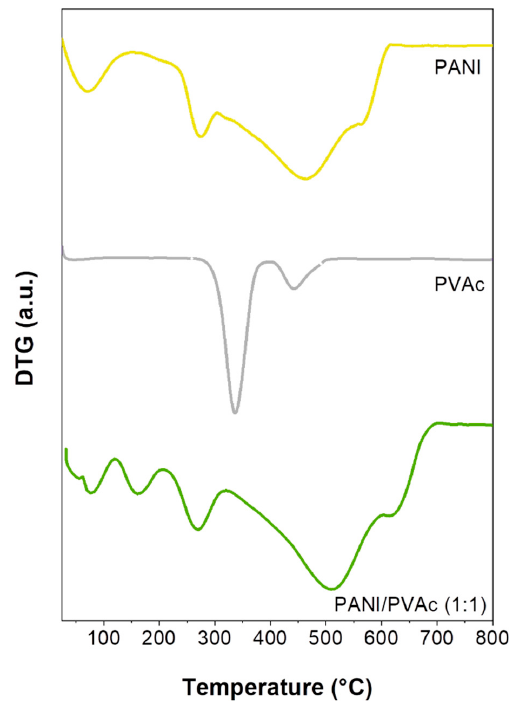
Figure 3. DTG profiles of different electrospun mats: PANI, PVAc and PANI/PVAc (1:1).